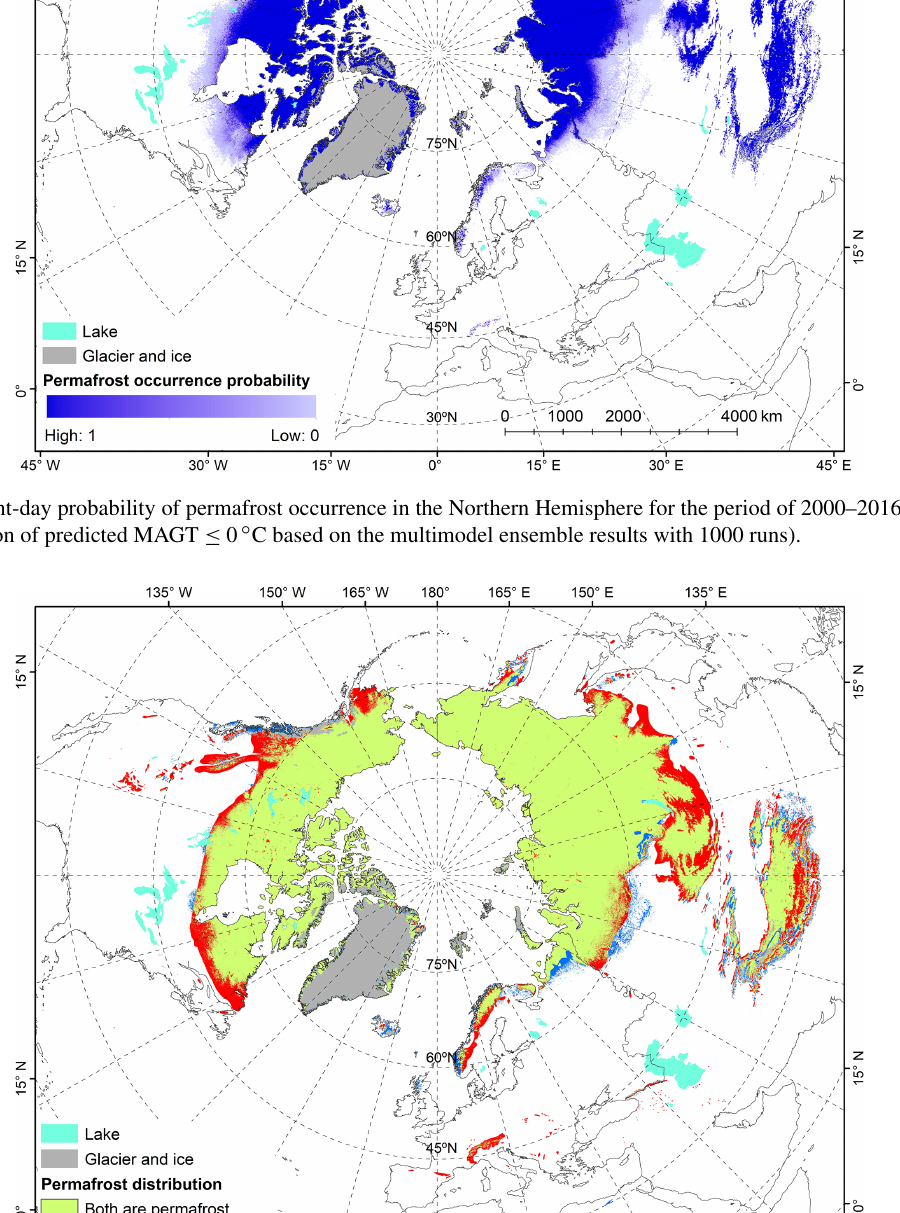
https://doi.org/10.5194/essd-14-865-2022 Earth Syst. Sci. Data, 14, 865–884,